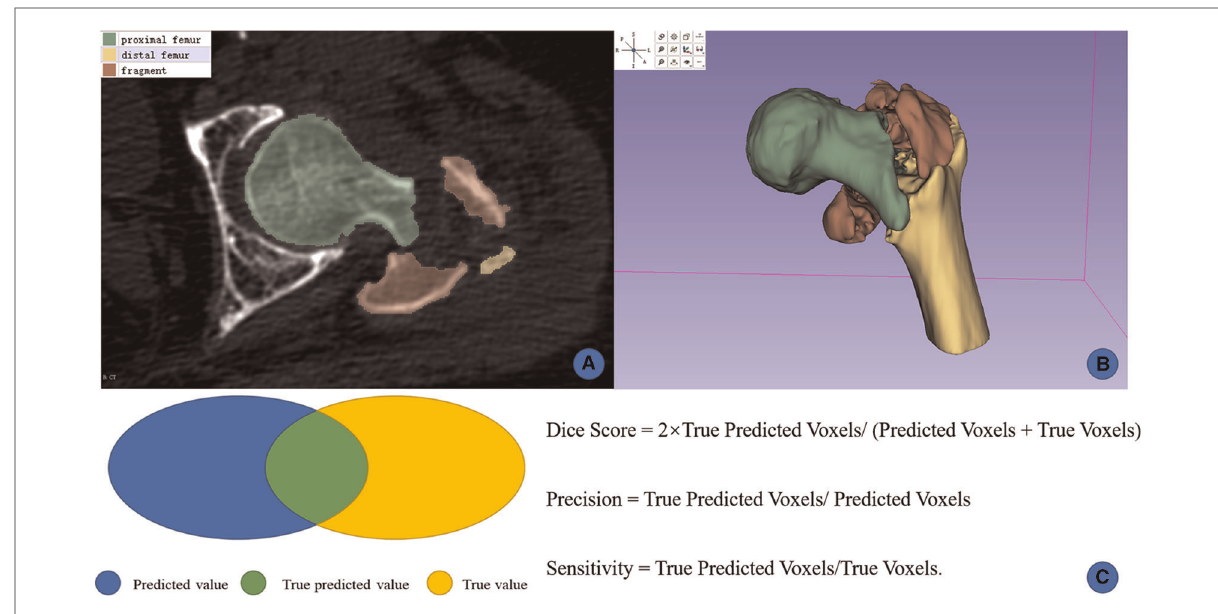
FIGURE 2 Manual segmentation and 3D reconstruction on slicer. ( A ) manual labels by human experts; ( B ) 3D reconstruction from 2D masks; ( C ) illustration of the Dice score, precision, and